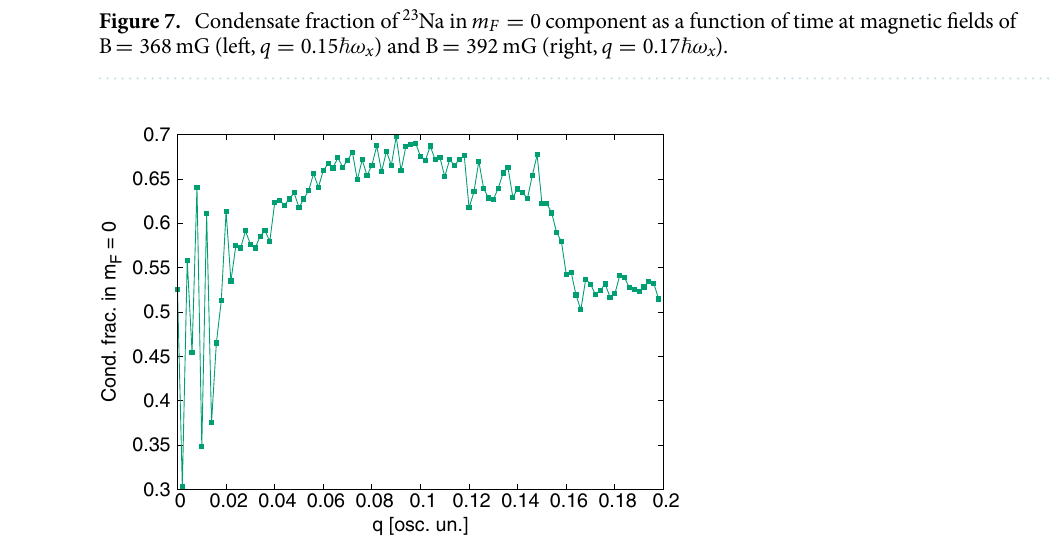
Figure 7. Condensate fraction of 23 Na in m F 368 mG (left, q B =